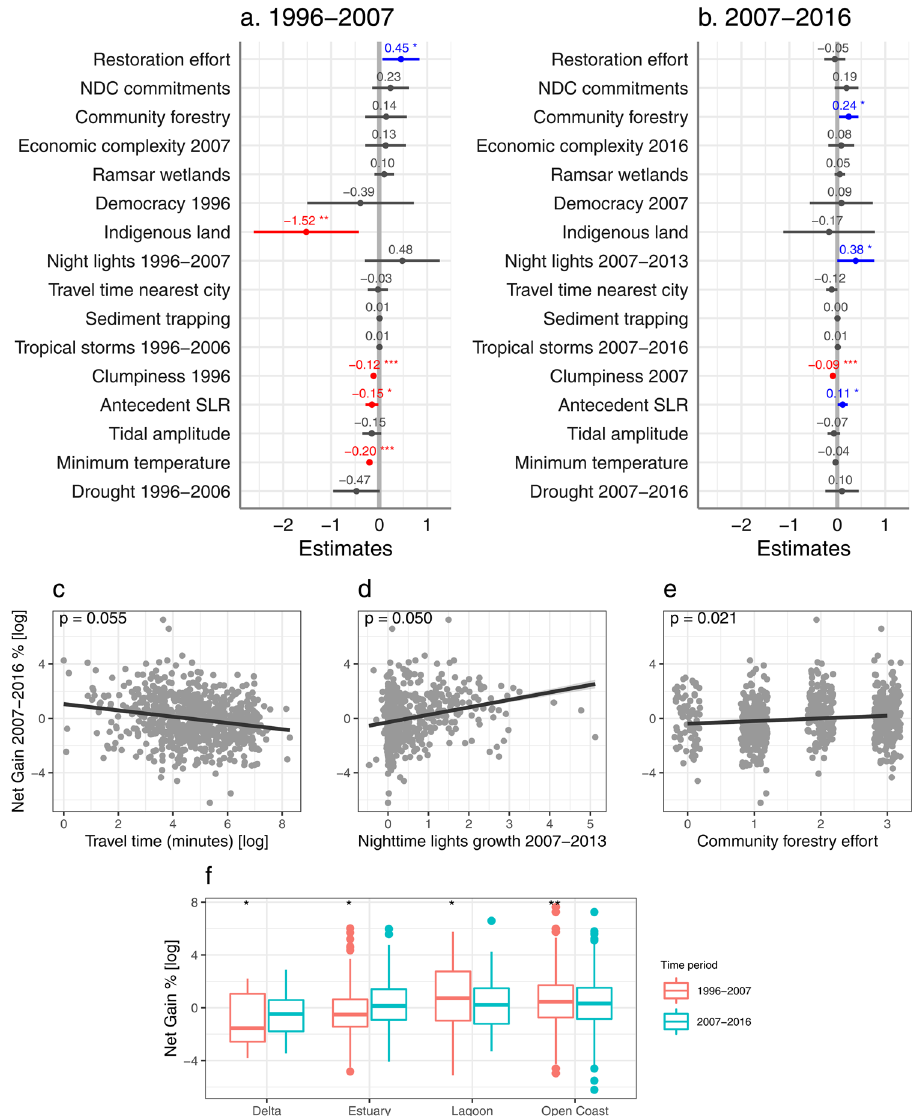
Fig. 4 | Global drivers of mangrove net gain. Fixed effects of socioeconomic and biophysical variables on percent net gain 1996 – 2007 ( a ; n = 451 mangrove geo- morphic units across 41 countries) and 2007 – 2016 ( b ; n = 743 mangrove geo- morphic units across 49 countries) showing the estimate and 95% con fi dence intervals from the mixed-effects models. Positive values (in blue) indicate that mangrove gain increased with an increase in the variable, while negative values (in red) indicate that mangrove gain decreased with an increase in the variable. NDC Nationally Determined Contribution. SLR sea-level rise. Relationship between percent net gain 2007 – 2016 and travel time to nearest city ( c ), night-time lights